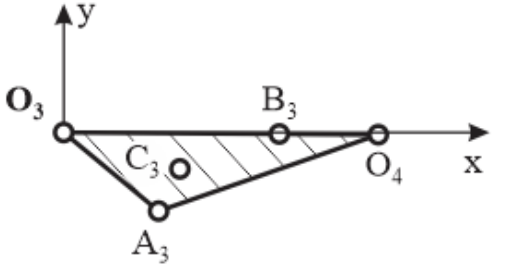
Figure 6. Schematic representation of the local coordinate system of arm no. 3.